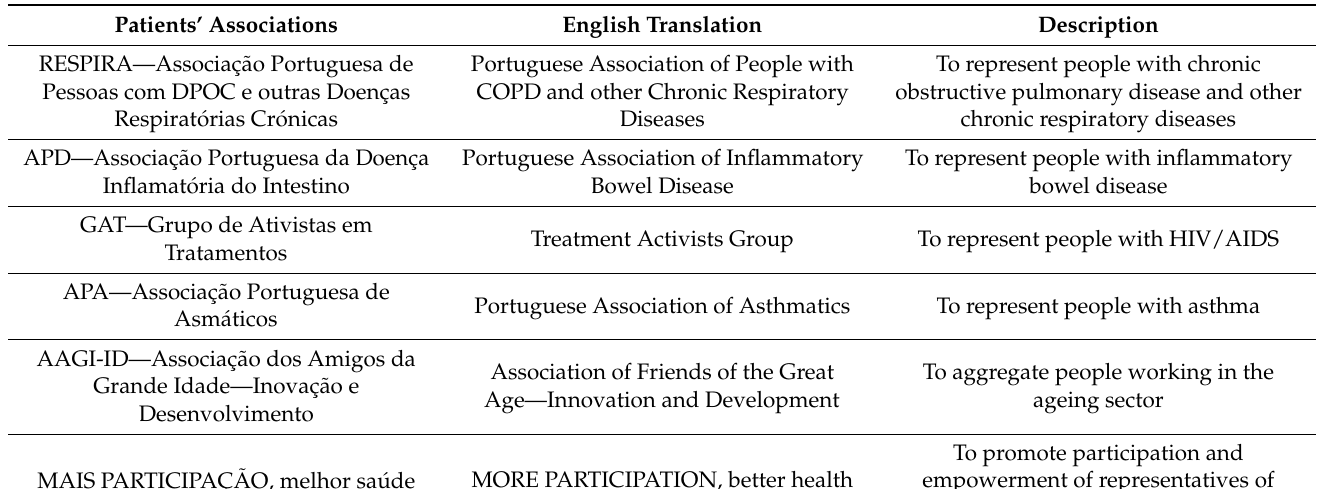
Table 2. Patients’ associations involved in semi-structured